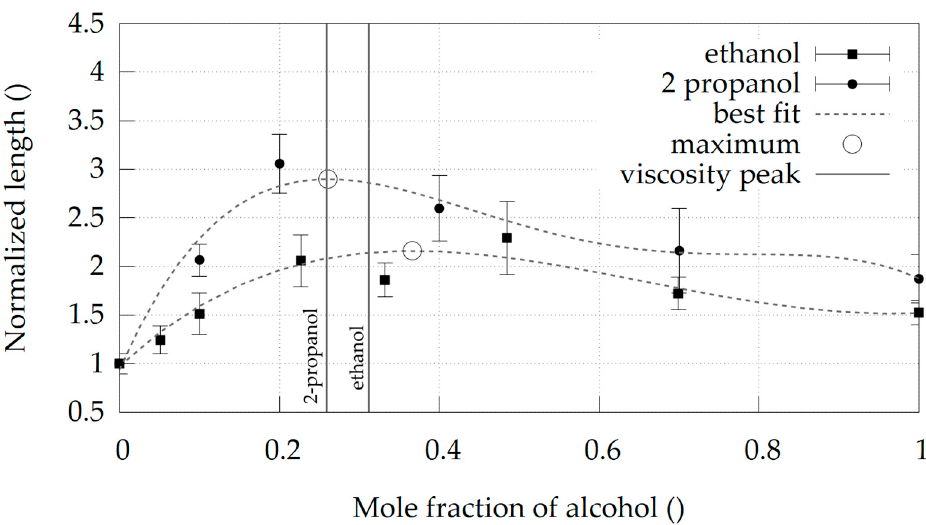
Figure 3. Normalized jet length at various molar fractions X i for two different alcohols. Black squares and dots denote the average length values, while the two dotted lines depict corresponding best fits to the available dataset (fourth-order polynomial). The maximum length in each system is marked by an empty circle. Black vertical lines denote the molar fraction at which a corresponding mixture reaches a viscosity peak. Error bars represent standard deviation.